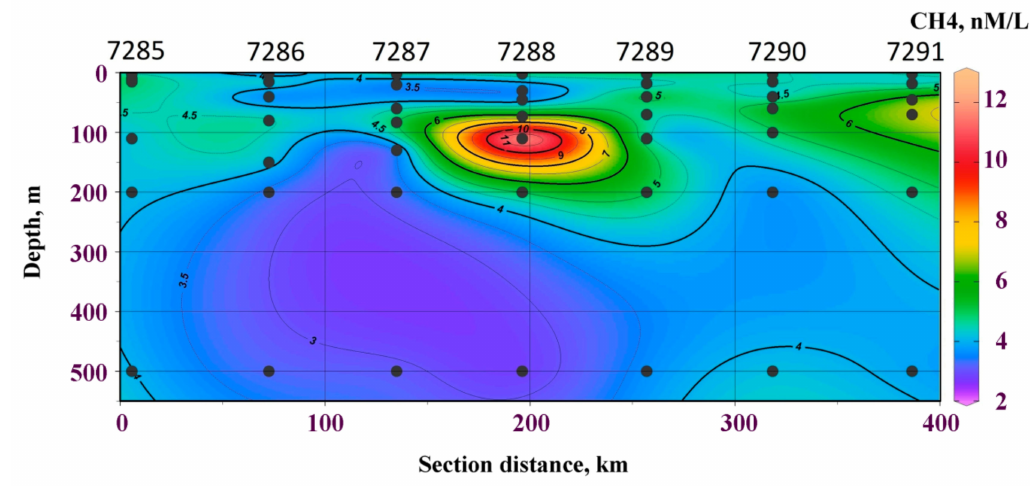
Figure 10. Distribution of methane concentration over the section.